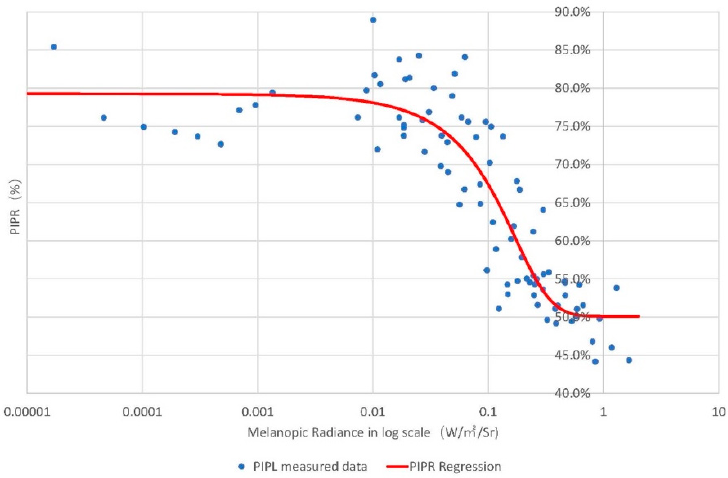
Figure 9. A regression model was developed using PIPR measurements as a function of melanopic radiance (in a logarithmic scale). The normalized PIPR values are represented with blue dots and the regression curve is shown in red. The model yields a high goodness of fit (0.818).